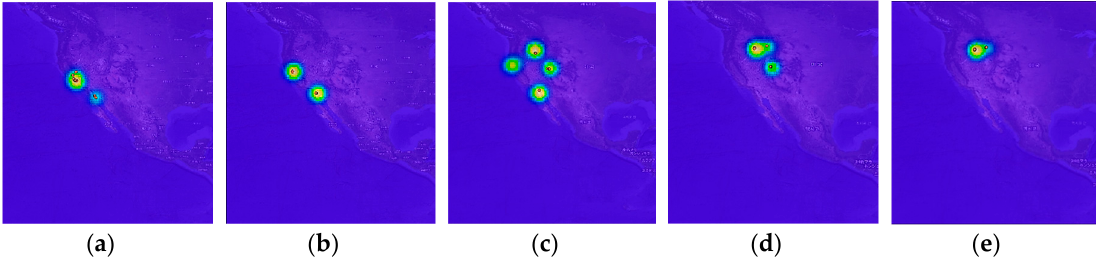
Figure 5. Examples of movement density sequence–( a ) 12 Dec. 2013 to 12 Jan. 2014; ( b ) 12 Jan. 2013 to 12 Feb. 2014; ( c ) 12 Feb. 2014 to 12 Mar. 2014; ( d ) 12 Apr. 2014 to 12 May 2014; ( e ) 12 May 2014 to 12 Jun. 2014.